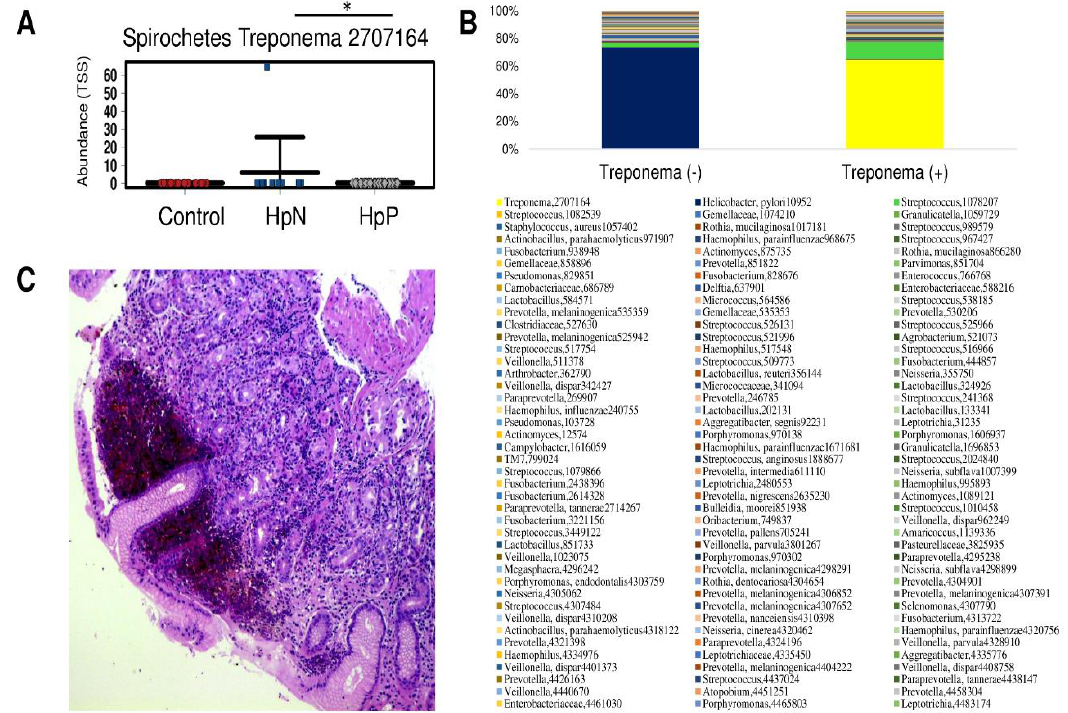
Figure 4. The rare case of syphilitic gastritis and its relative abundance. The mean abundance value of Treponema (OUT ID 2707164) at the species level was high in HpN compared with the HpP and control group ( A ); its relative abundance is shown for Treponema negative and Treponema positive cases ( B ) with its gastric histopathological image ( C ). Inflammatory cell accumulation with hemorrhagic change was observed by hematoxylin and eosin staining in Treponema positive patient by 16S rRNA. * p < 0.05.